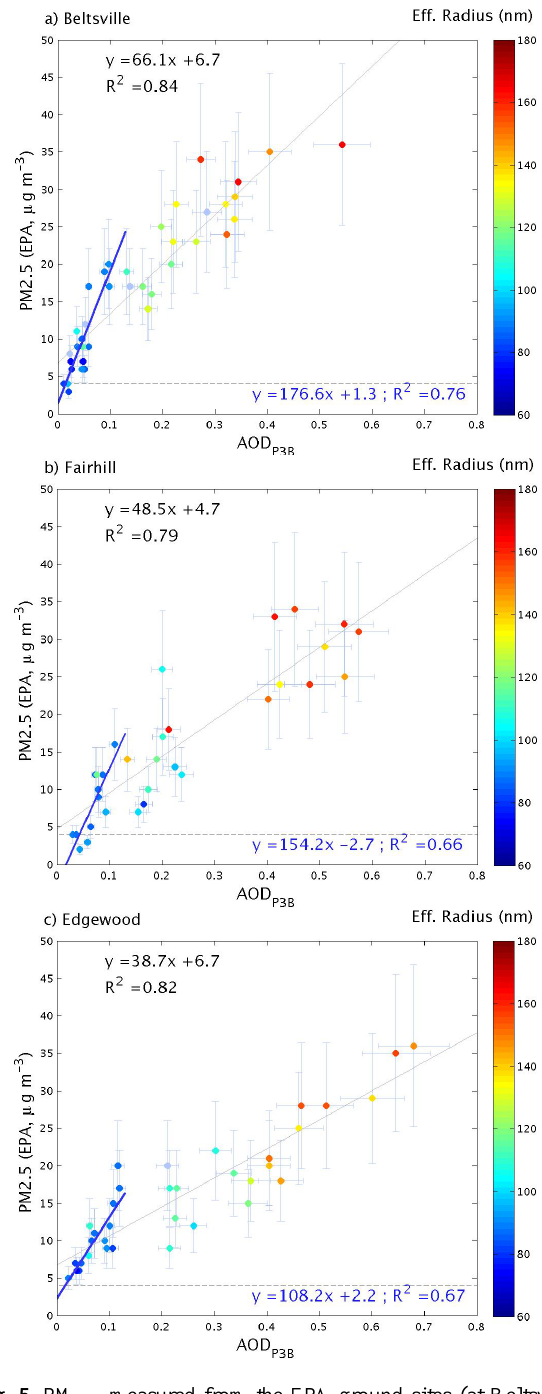
Fig. 5. PM 2 . 5 measured from the EPA ground sites (at Beltsville (a) , Fairhill (b) , and Edgewood (c) ) as a function of the AOD (550nm) calculated using extinction profiles performed by the P- 3B. The color code represents the effective radius (nm). The hori- zontal dashed line corresponds to the detection limit of the BAM (4µgm − 3 ). The error bars correspond to the measurement vari- ability ( ± 1 σ ). The grey fit (equation in black) is for all retrieved AOD values, while the blue fit is for cases with prevalent fine-mode aerosols ( R eff